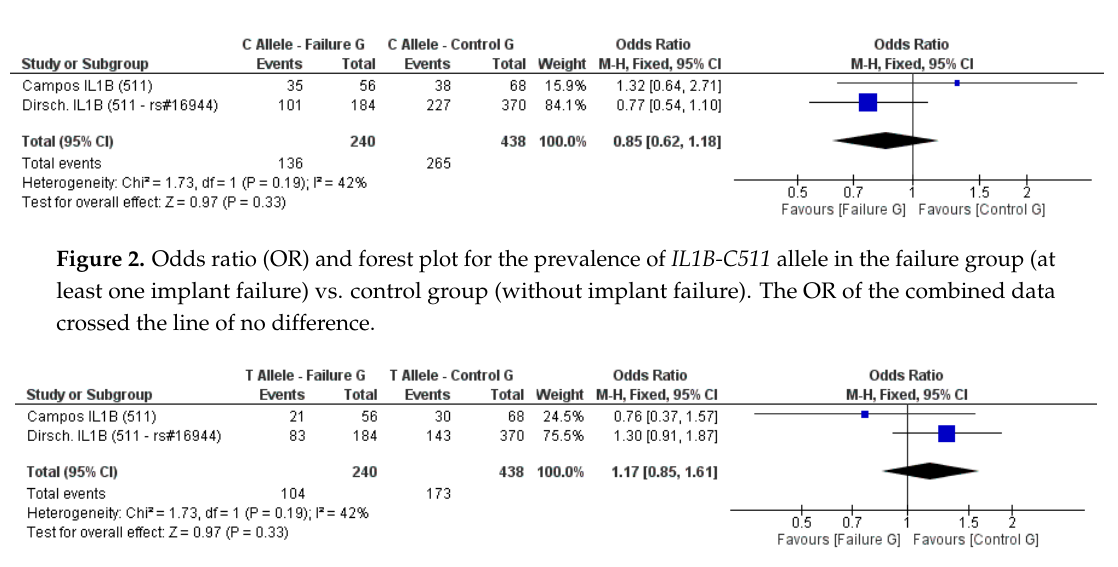
Figure 3. Odds ratio and forest plot for the prevalence of the IL1B-T511 allele in the failure group (at least one implant failure) vs. control group (without implant failure). The OR of the combined data crossed the line of no difference.